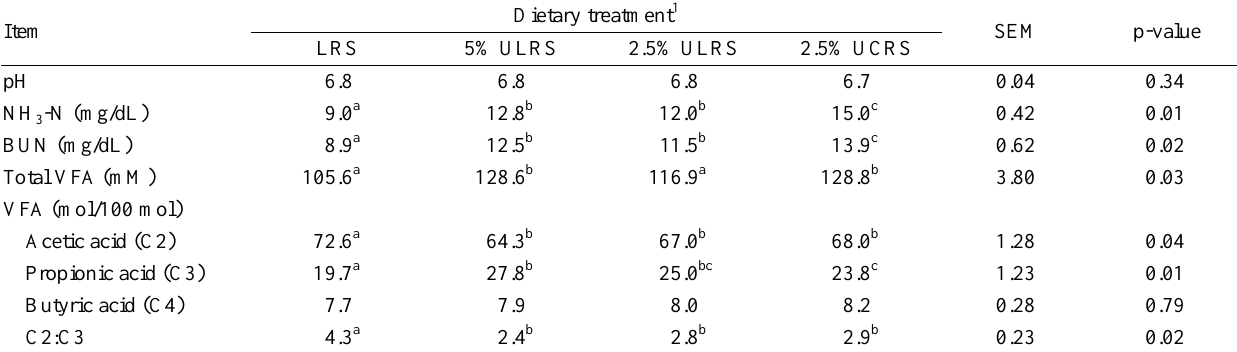
Table 3. Effects of physical forms and urea treatment of rice straw on rumen fermentation and BUN in lactating dairy cows